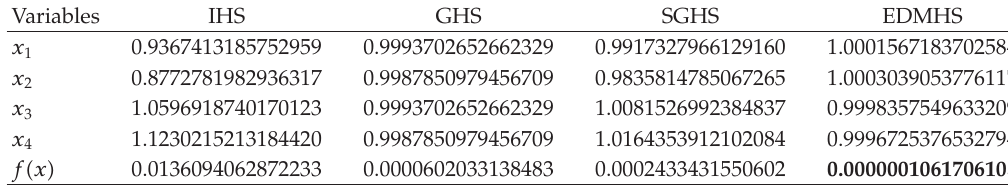
Table 4: Four HS algorithms for Wood